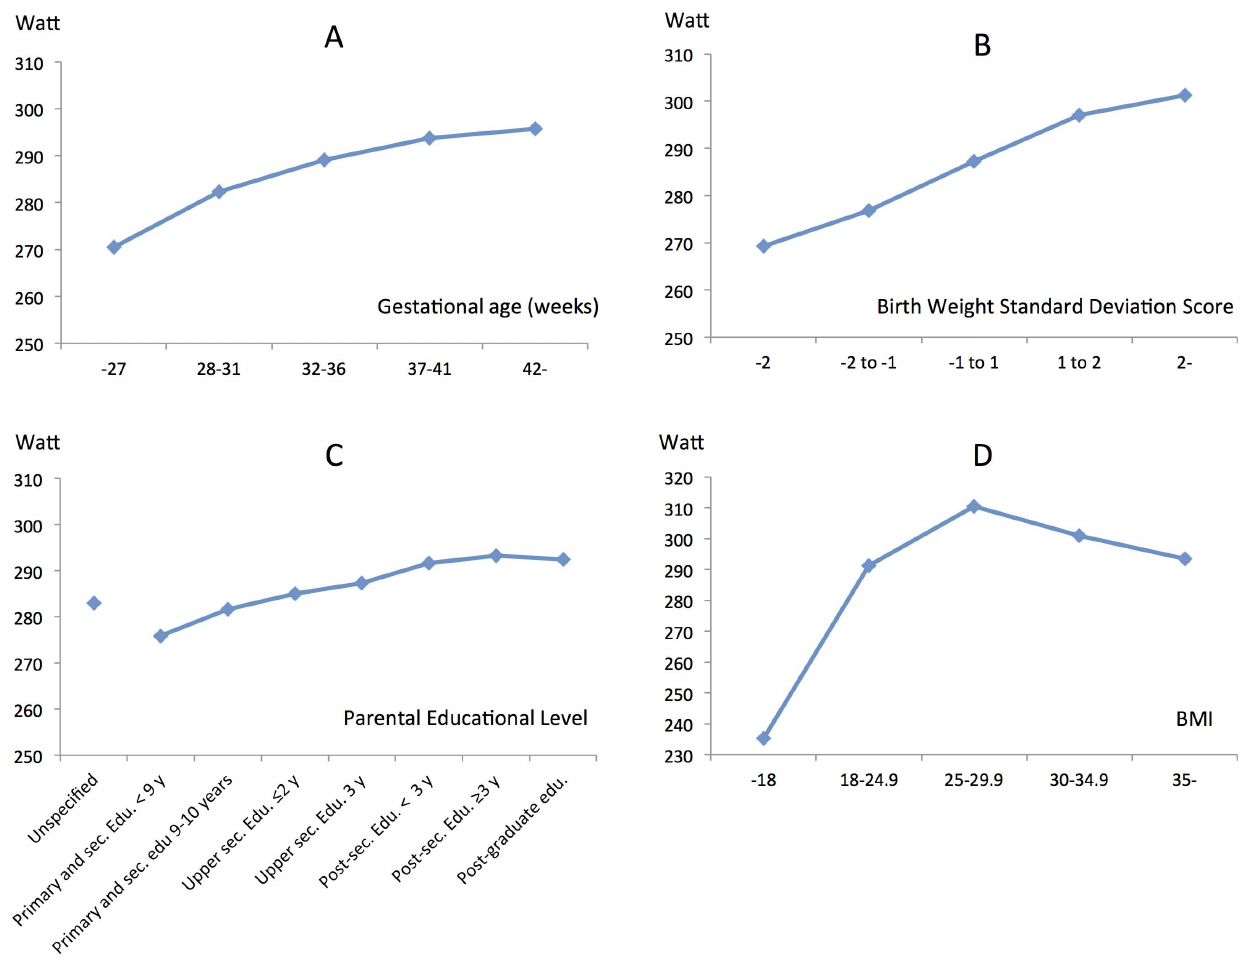
Figure 2. Maximal exercise capacity. Adjusted results expressed as least squared means for maximal exercise capacity (Watt) in relation to the major risk factors. A - Gestational Age categories, B - Birth Weight Standard Deviation Score, C – Education level of the parents and D - BMI. Sec edu.=Secondary education, y=years, BMI=Body Mass Index.